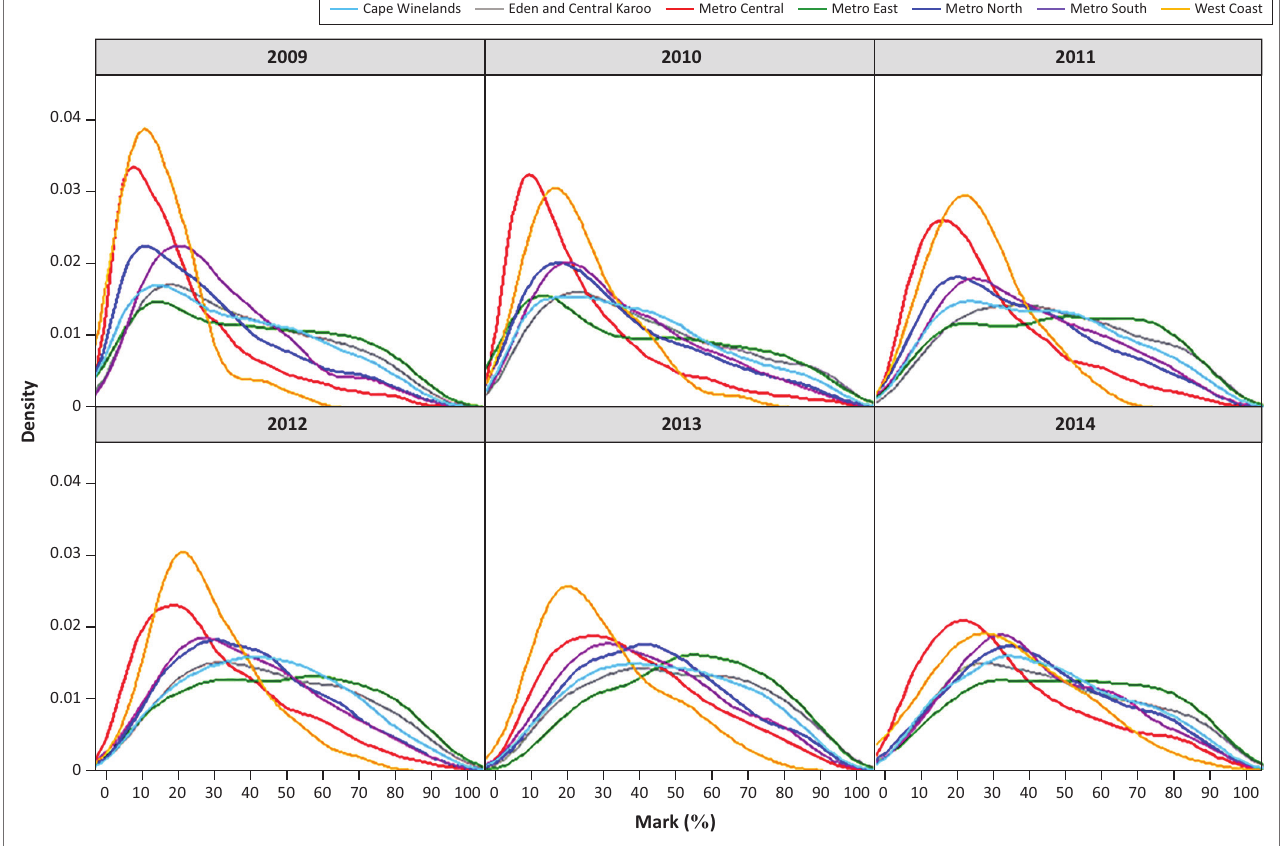
FIGURE 2: Distribution of mathematics examination marks by education district 2009–2014 for learners in the Western Cape.